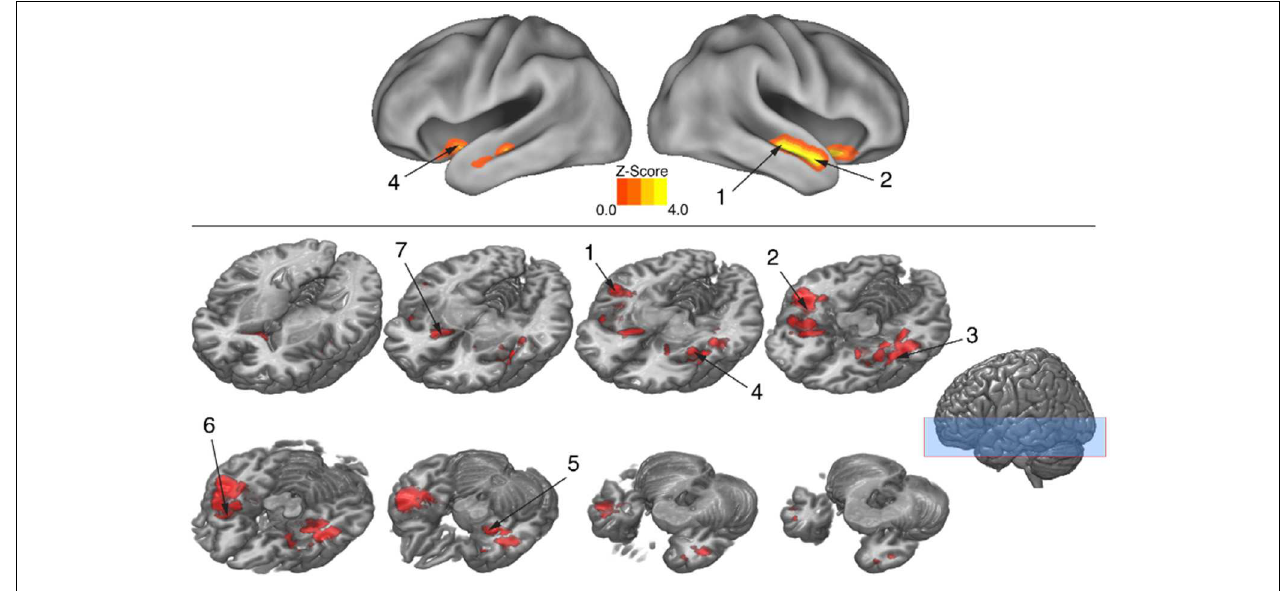
relative to repeated themes was evidence of RS. Given that the intended theme of a performance was the only element that was repeated between trials, regions showing RS revealed brain substrates that were sensitive to the specific meaning infused into a movement sequence by a performer. Number labels correspond to those listed in Table 3 , which provides anatomical names and voxel coordinates for key clusters showing significant RS. Blue shaded area indicates vertical extent of axial slices